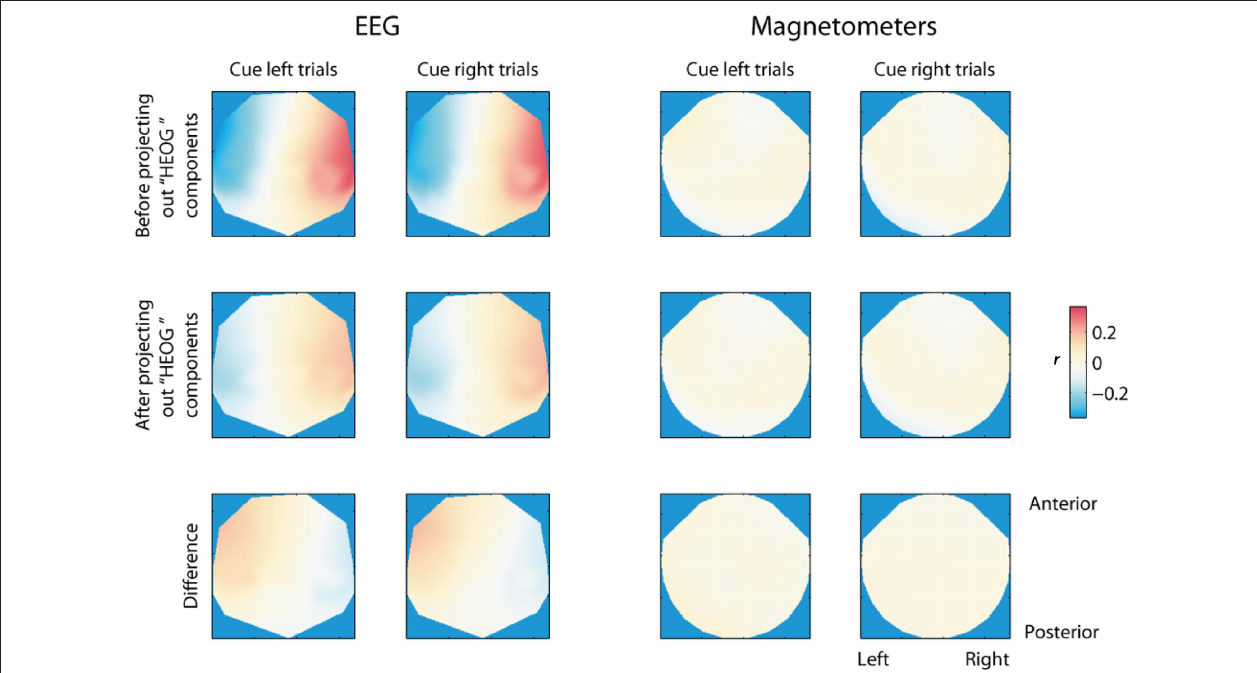
Figure A5 | Correlation between the signal at the HeOg channel and at the other